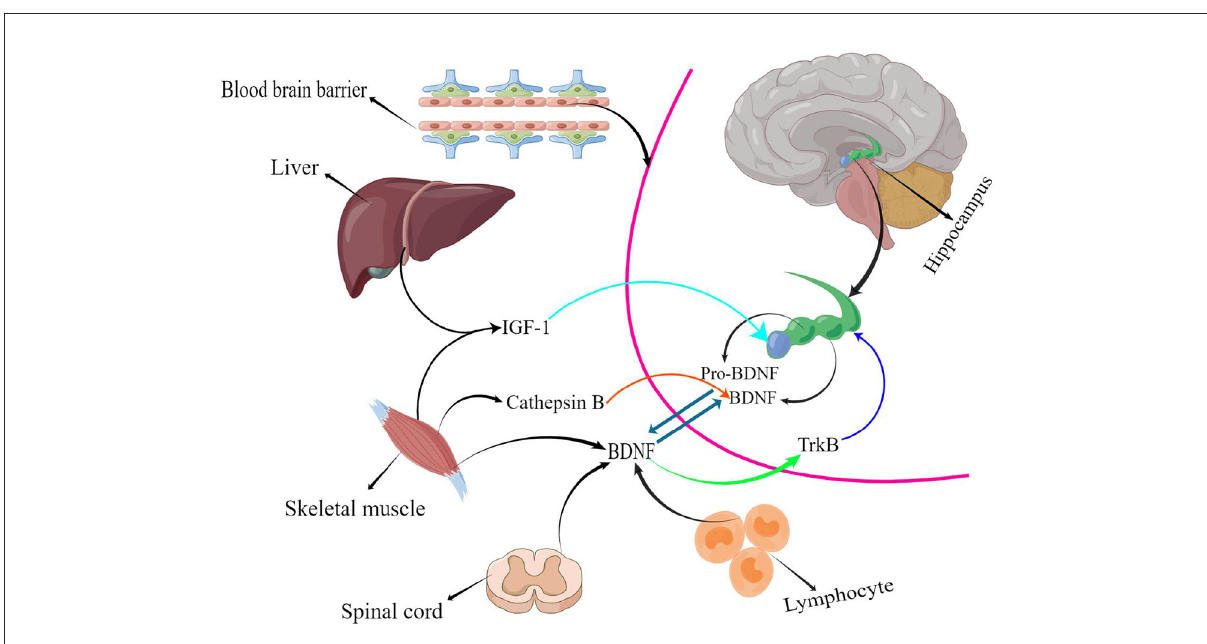
FIGURE6 Exercise mediated peripheral cytokines(By